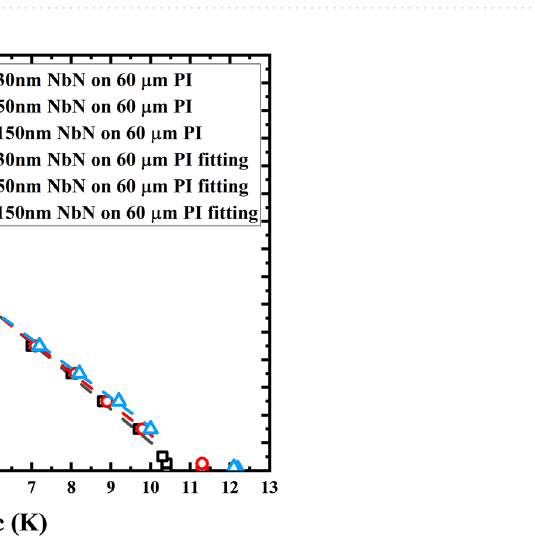
Figure 6. R-T curve of NbN films on 60 μm PI under different magnetic field: ( a ) 30 nm NbN ( b ) 50 nm NbN ( c ) 150 nm NbN.